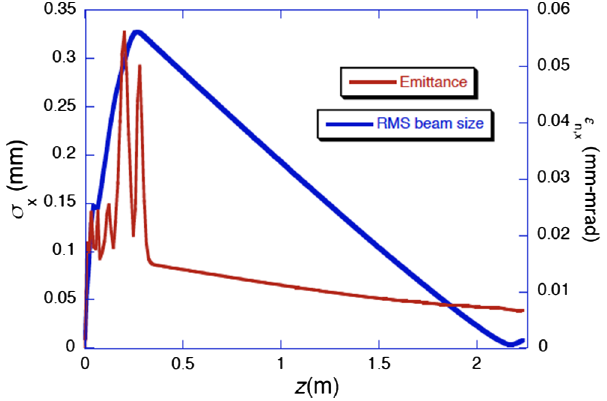
FIG. 5. Beam emittance evolution in low-charge, cigar-beam case, showing an emittance compensated down to ε 0 . 005 mm-mrad level with 1.3 A peak